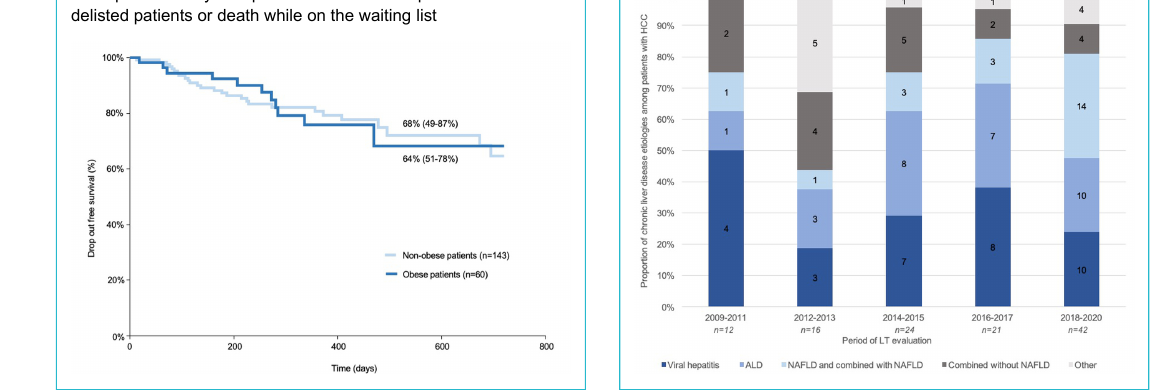
Figure 6: Causes of chronic liver disease among patients with he- patocellular carcinoma (HCC). Proportions of different chronic liver disease aetiologies among patients with hepatocellular carcinoma evaluated for liver transplantation (y axis, %) are represented by columns over five time periods (x axis, year). The distributions of different aetiologies varied significantly over time (p =